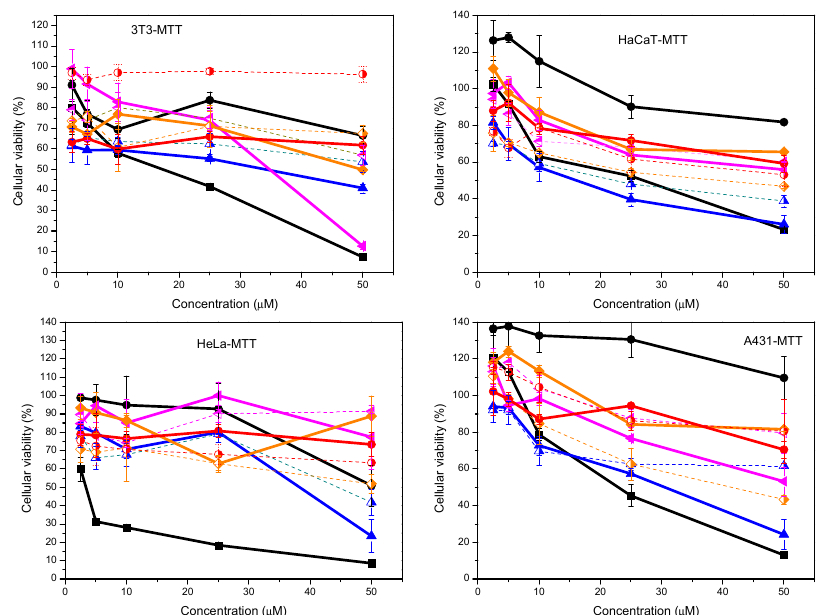
Figure 8. Cellular viability (%) as a function of concentration for different cellular lines using the MTT test: Histidine, Sodium myristate, 80:20 HM,